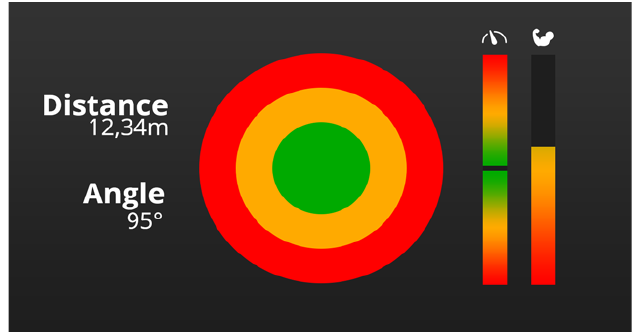
Figure 10. Screenshot of the ArcAid smartphone application.